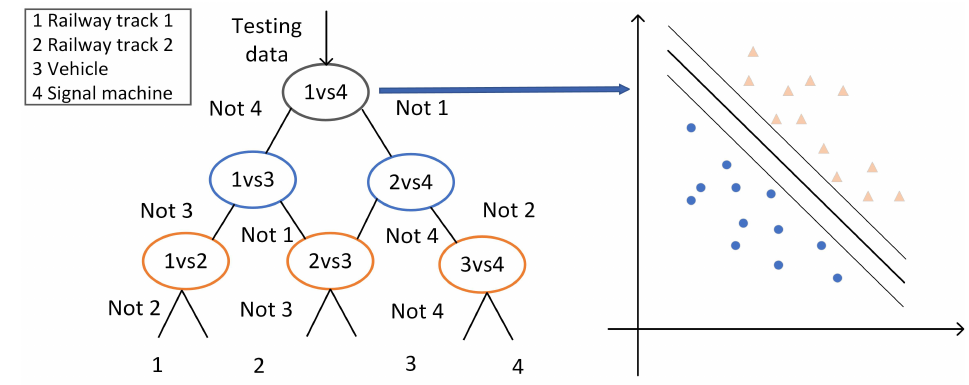
Figure 4. The decision-making process of the four-class classifier based on the DAG-SVM method. According to Section 4.2, f n = [ µ n , h n , g n , u n ] , which is the feature set